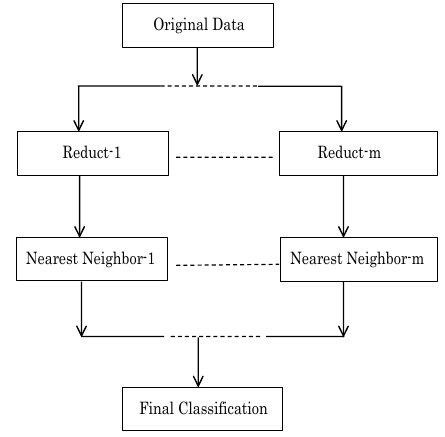
Fig. 1. Classification by using